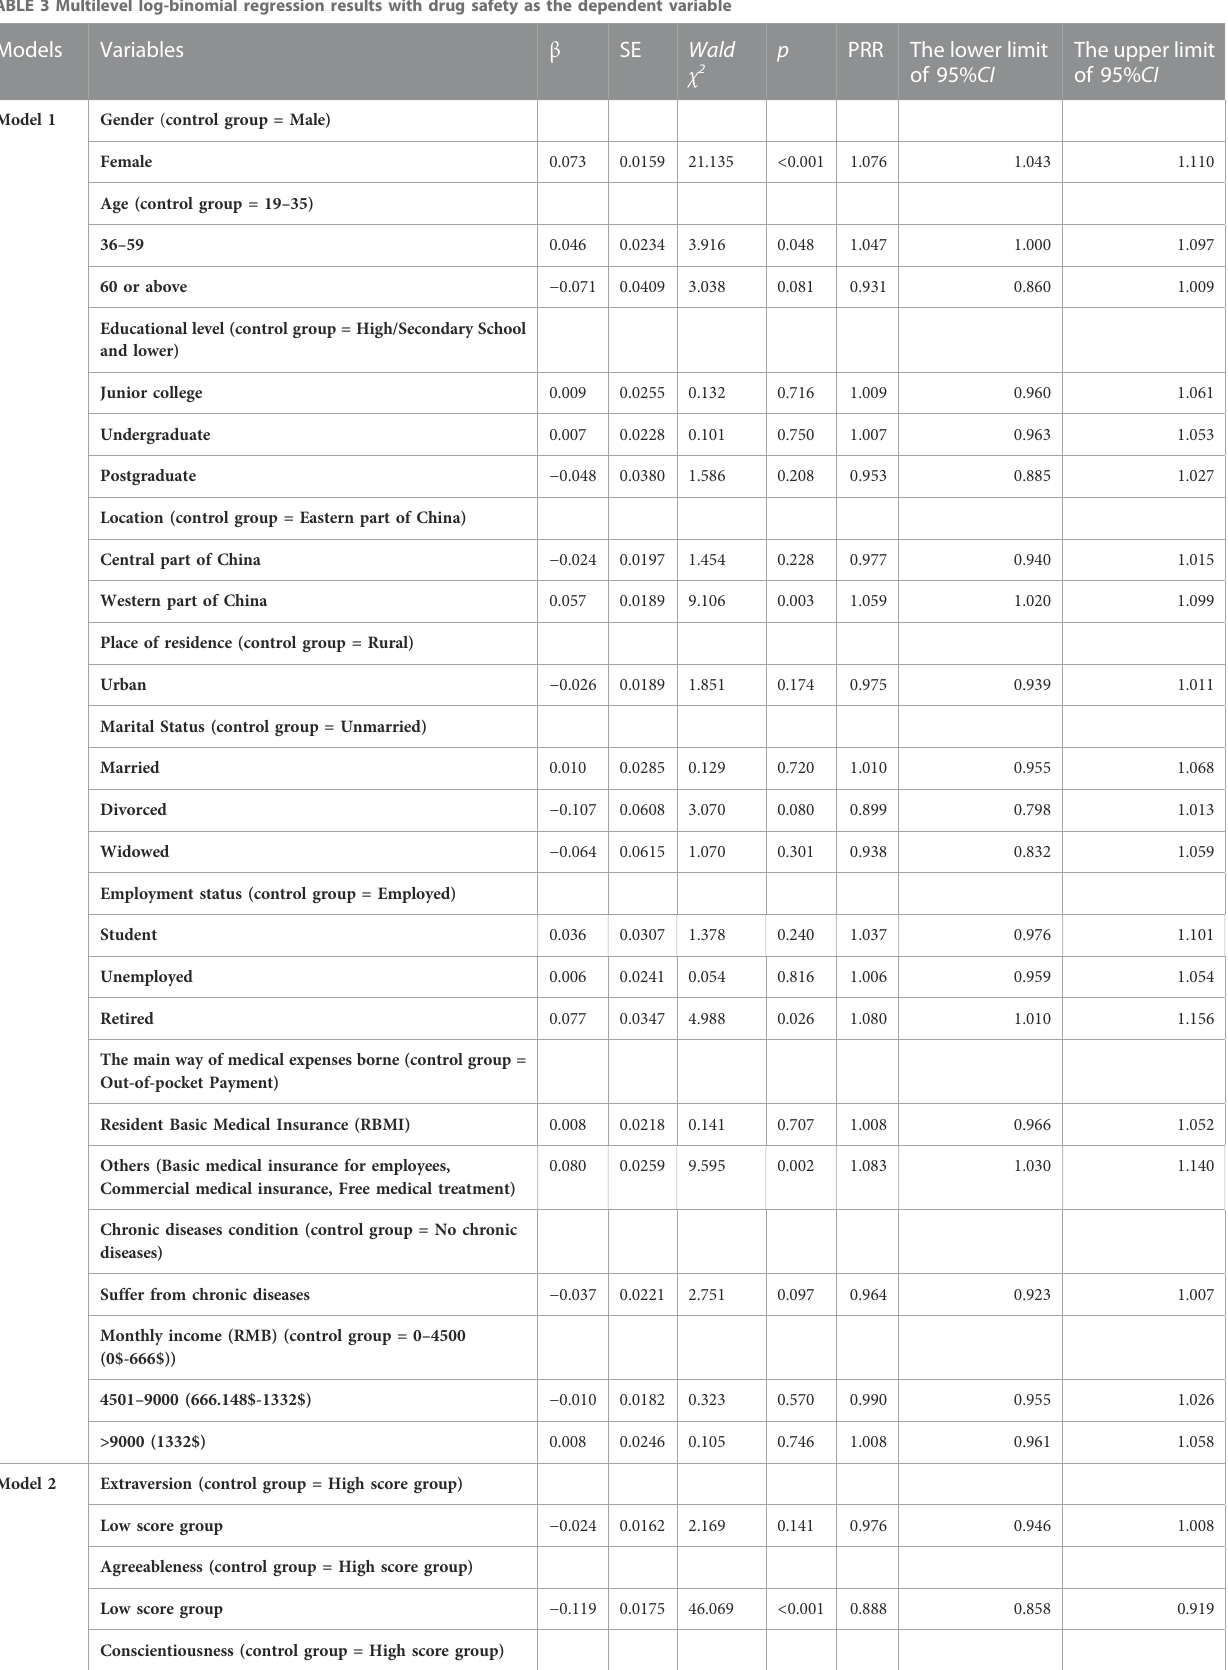
TABLE 3 Multilevel log-binomial regression results with drug safety as the dependent variable